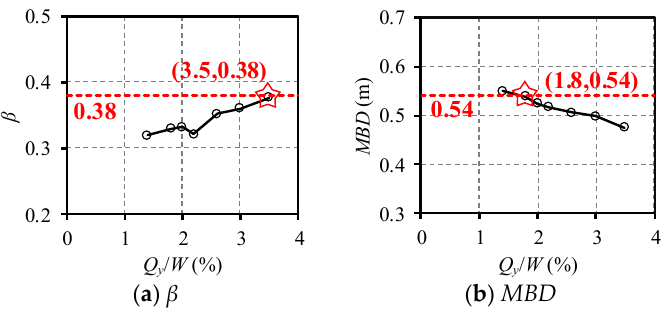
Figure 5. C1 with conventional base ‐ isolated (CBI) scheme.